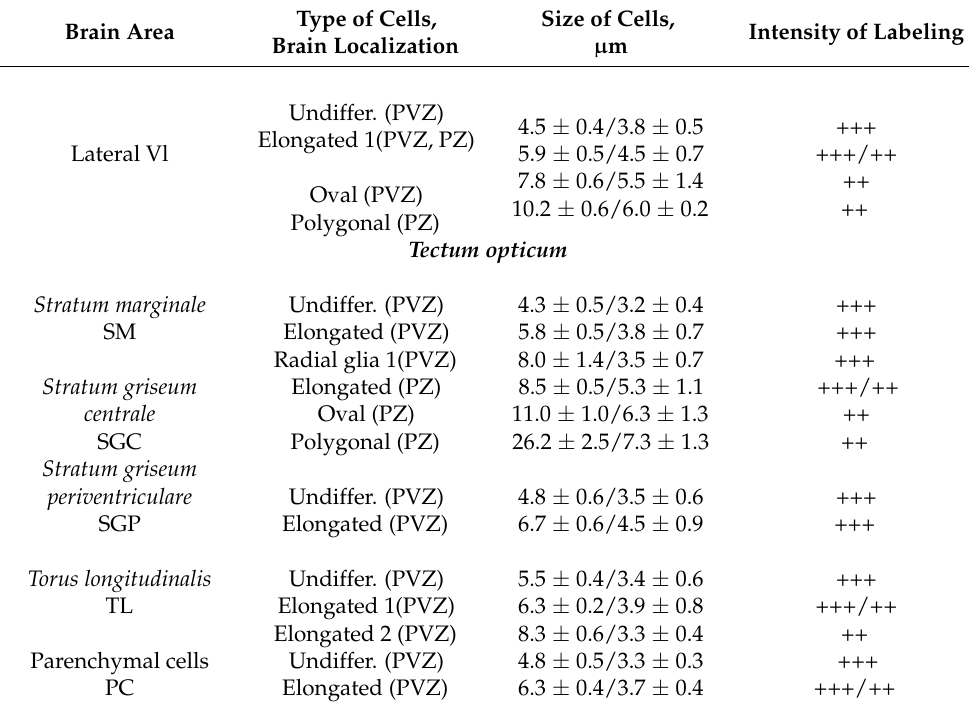
Table 4. Cont. Brain Area